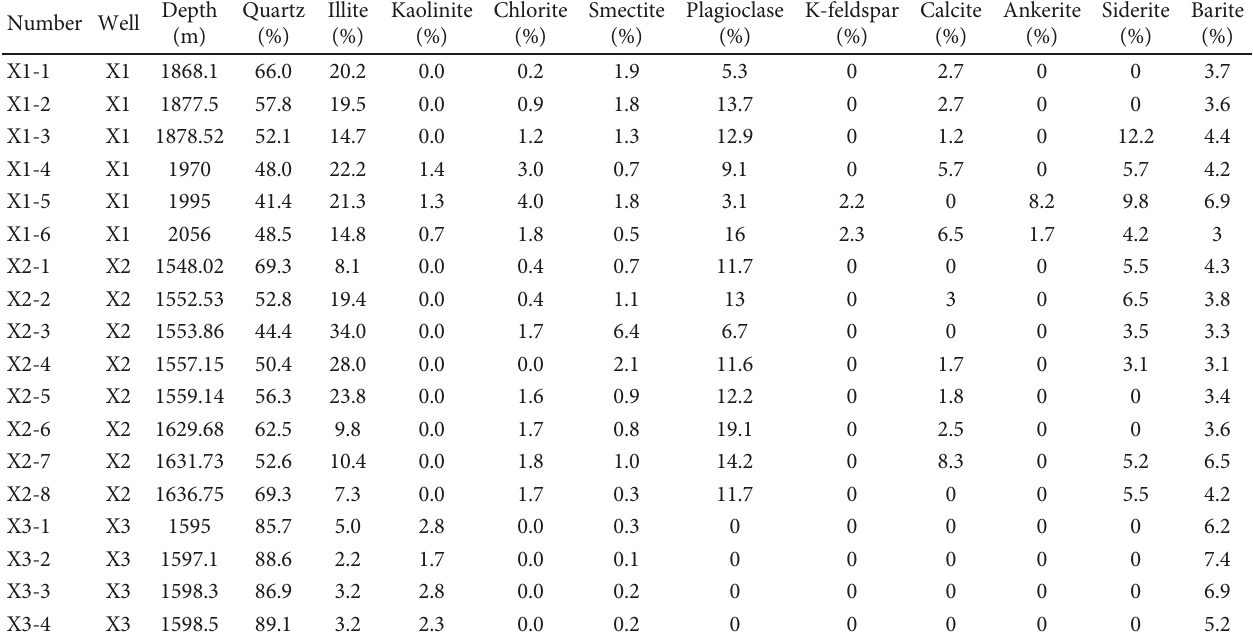
Figure 3: The burial history curve of the Longtan Formation (P Table 1: Volume fractions of minerals in sandstone samples taken from the Longtan Formation (converted from XRD analysis data). Depth Number Well